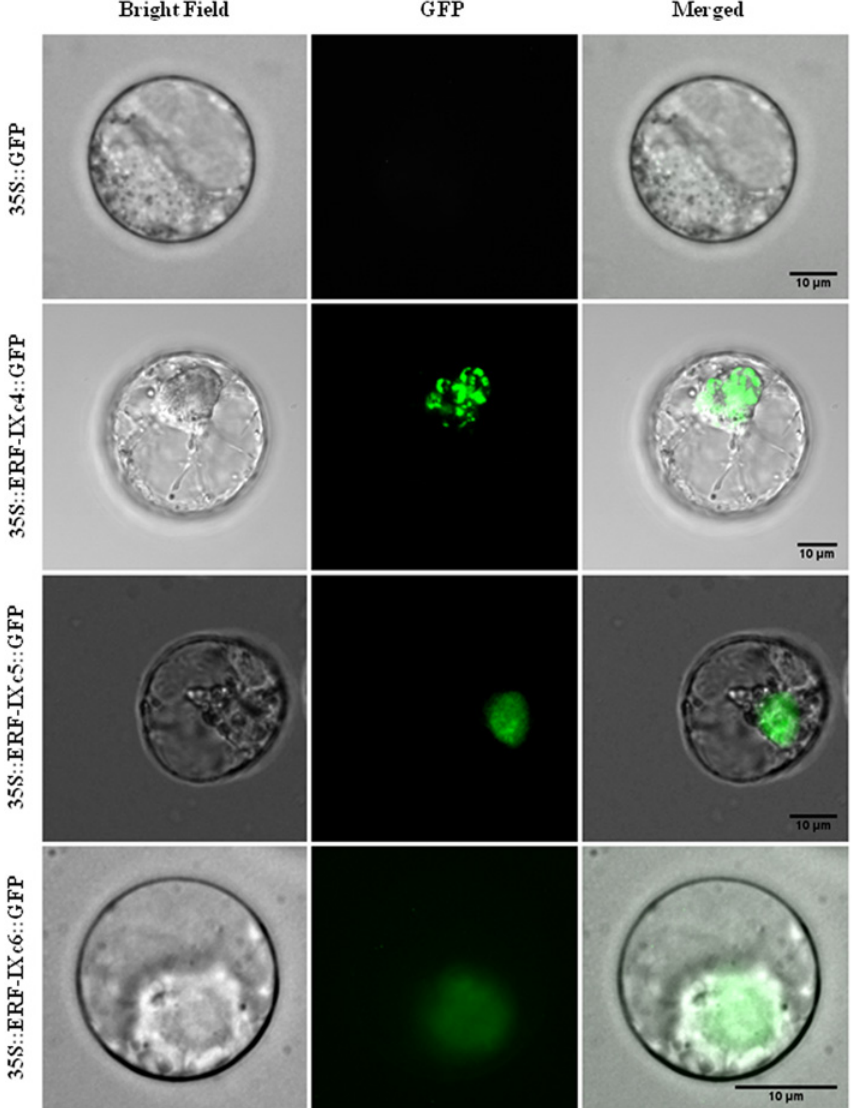
Fig 5. Subcellular localization of HbERF-IXs. The merged pictures of the green fluorescence channel (middle panels) and the corresponding bright field (left panels) are shown (right panels). Control cells expressing fluorescence absence are shown in the top panel. The scale bar indicates 10 μ